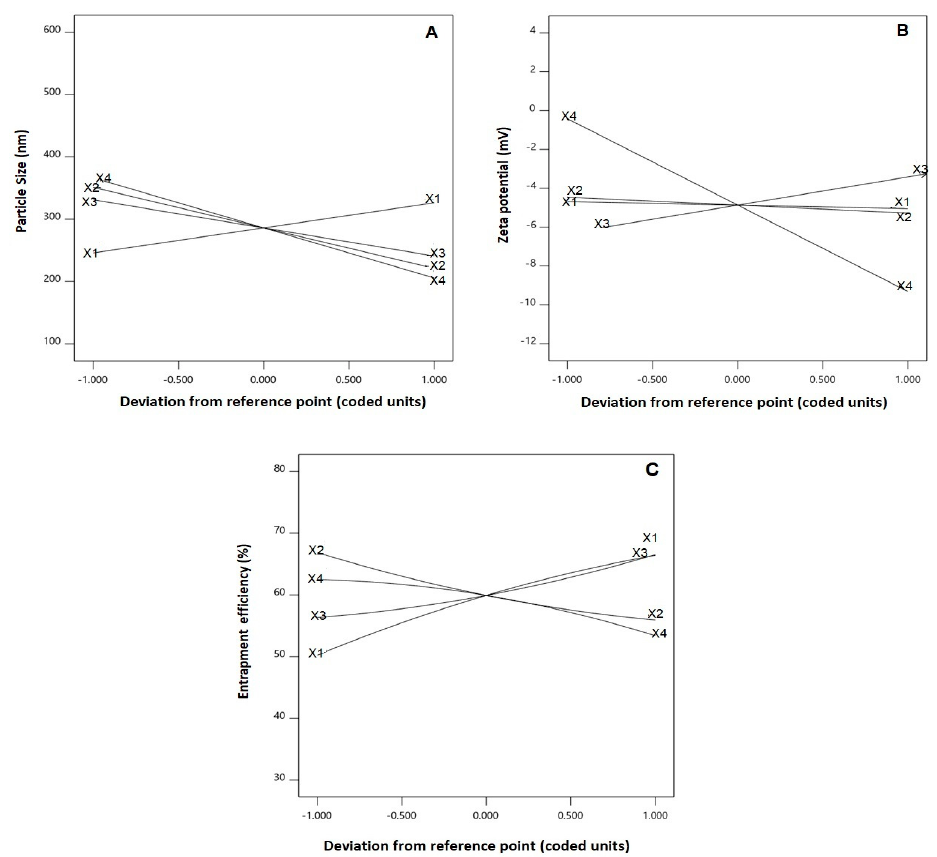
Figure 2. Perturbation graph for the main effects of critical attributes; ICA concentration (X 1 ), TPGS concentration (X 2 ), zein concentration (X 3 ), and SDC concentration (X 4 ) on ( A ) particle size, ( B ) zeta potential, and ( C ) EE% of ICA–tocozeinolate nanospheres.